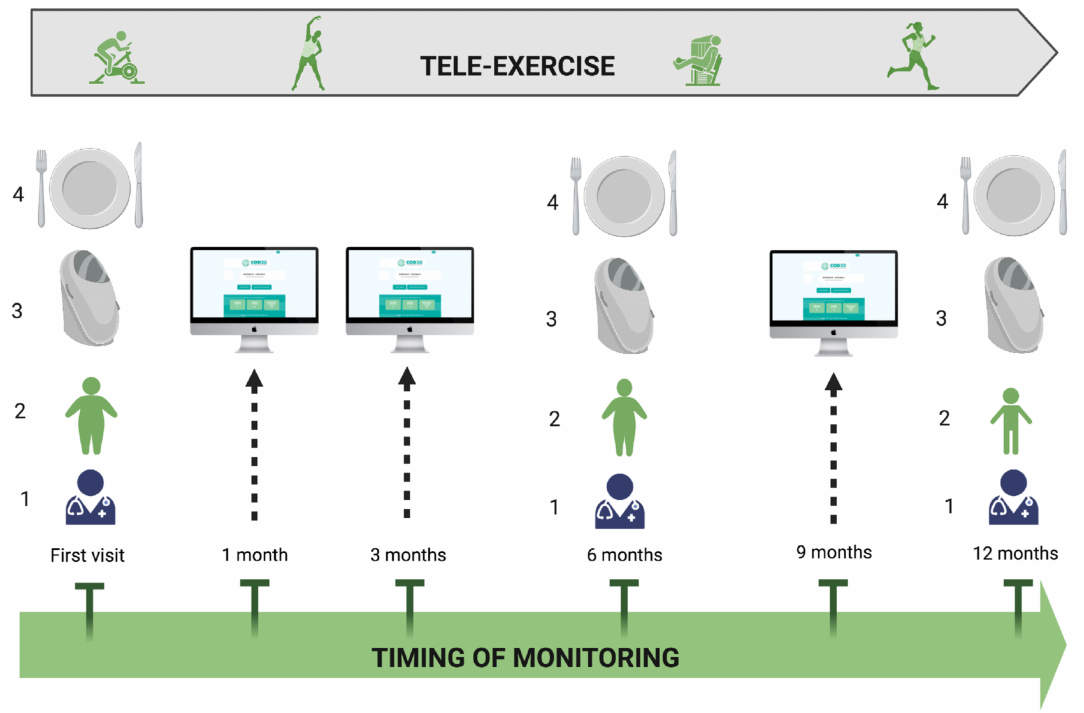
Figure 4. Integrated care model for childhood obesity, combining telehealth and face-to face visits. Face-to face visit is proposed at the first evaluation and at 6- and 12-month follow-up; clinical evaluation (1), body weight control (2), body composition evaluation (3), and nutritional counseling (4) are included. At 1-, 3-, and 9-month follow-up. Tele-consultation for monitoring of weight, dietary intake, and physical activity is provided. During follow-up, a supervised exercise training program is remotely delivered three times per week in a 30–45 min session (created with BioRender.com, accessed on 16 October